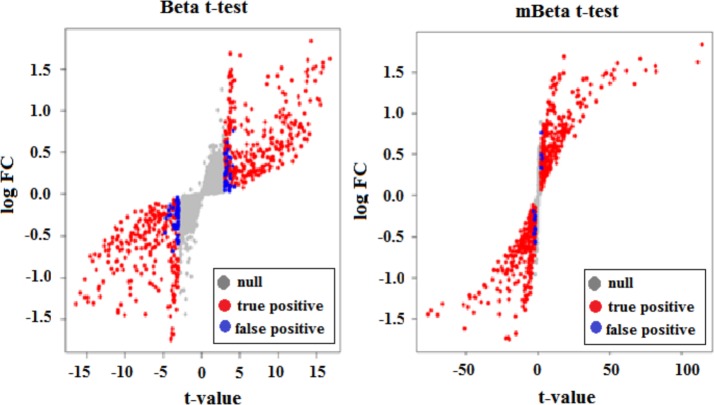
Plot of Log Fold Change versus t-statistics.
t-values were obtained by the two Beta t-test methods from the simulated data in which values τ = 100U were assigned to 10% of genes for differential expression between two given conditions each with three replicates. LogFC on y-axis represents log fold change in expression. In the Beta t-test method (A), t-value was distributed in the interval between -16 and 16 and acceptable region for non-differential expression was spanned from -4.0 to 4.0. Many false positives (blue dots) were found in two rejection areas. But in the mBeta t-test method (B), the interval for t-values was enlarged to span from -70 to 120 and the acceptable region for non-differential expression was strongly compressed into a narrow interval close to zero so that few false positives (blue dots) were found in rejection areas.